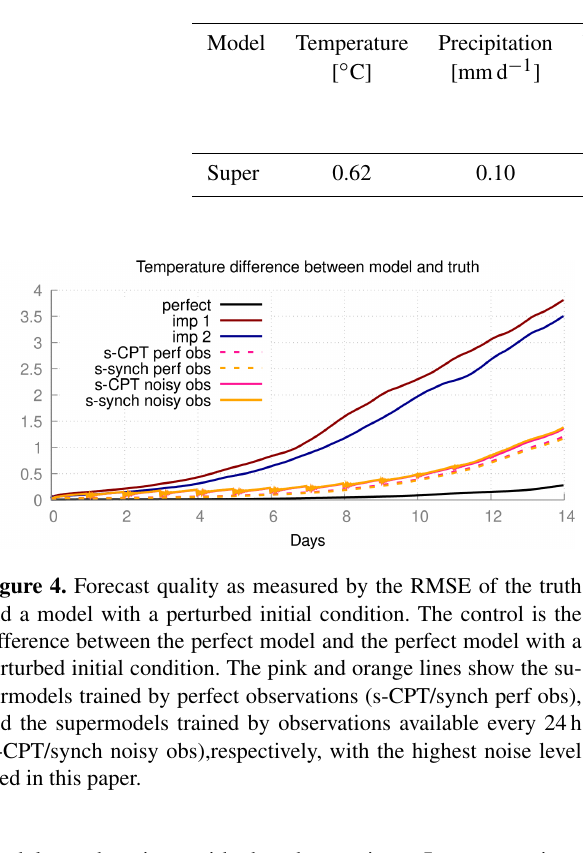
Table 6. Global mean average difference between the supermodel with negative weights and the perfect model, calculated over the last 30 years of the simulation.